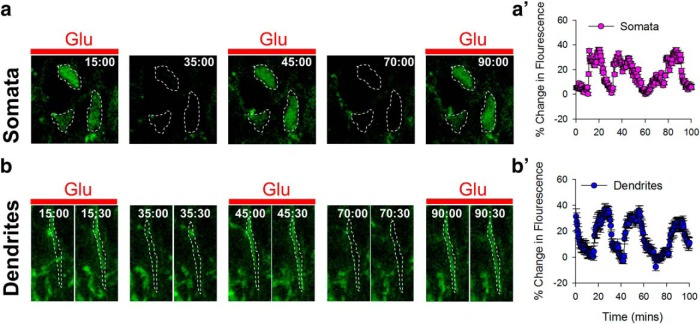
Neurons respond functionally to multiple hits of glutamate. Images (a, b) and time series (a′, b′) data showing intracellular calcium transients in neuronal somata (top) and dendrites (bottom) from GCaMP2.2 mouse slices after repeated glutamate (1 mm) treatment in cortical layer II/III.